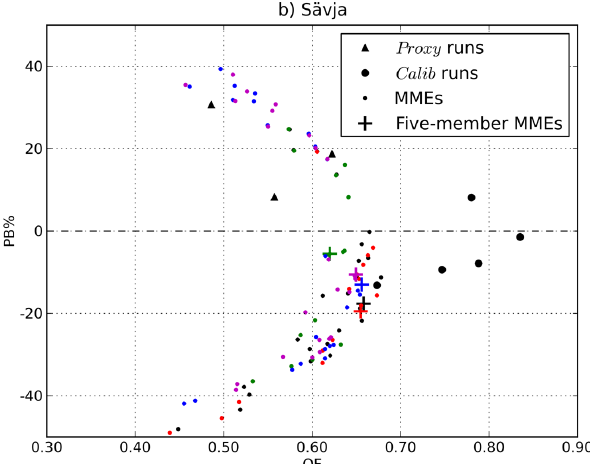
Fig. 3b. Criteria value for the different multi-model ensemble (MME) predictions at S¨avja. Two poor Proxy runs with low OF values are not shown and colours correspond to the different data- fusion methods (red: ME; black: WM; green: MD; blue: UR; ma- genta: CR; see Table 2 for abbreviations).